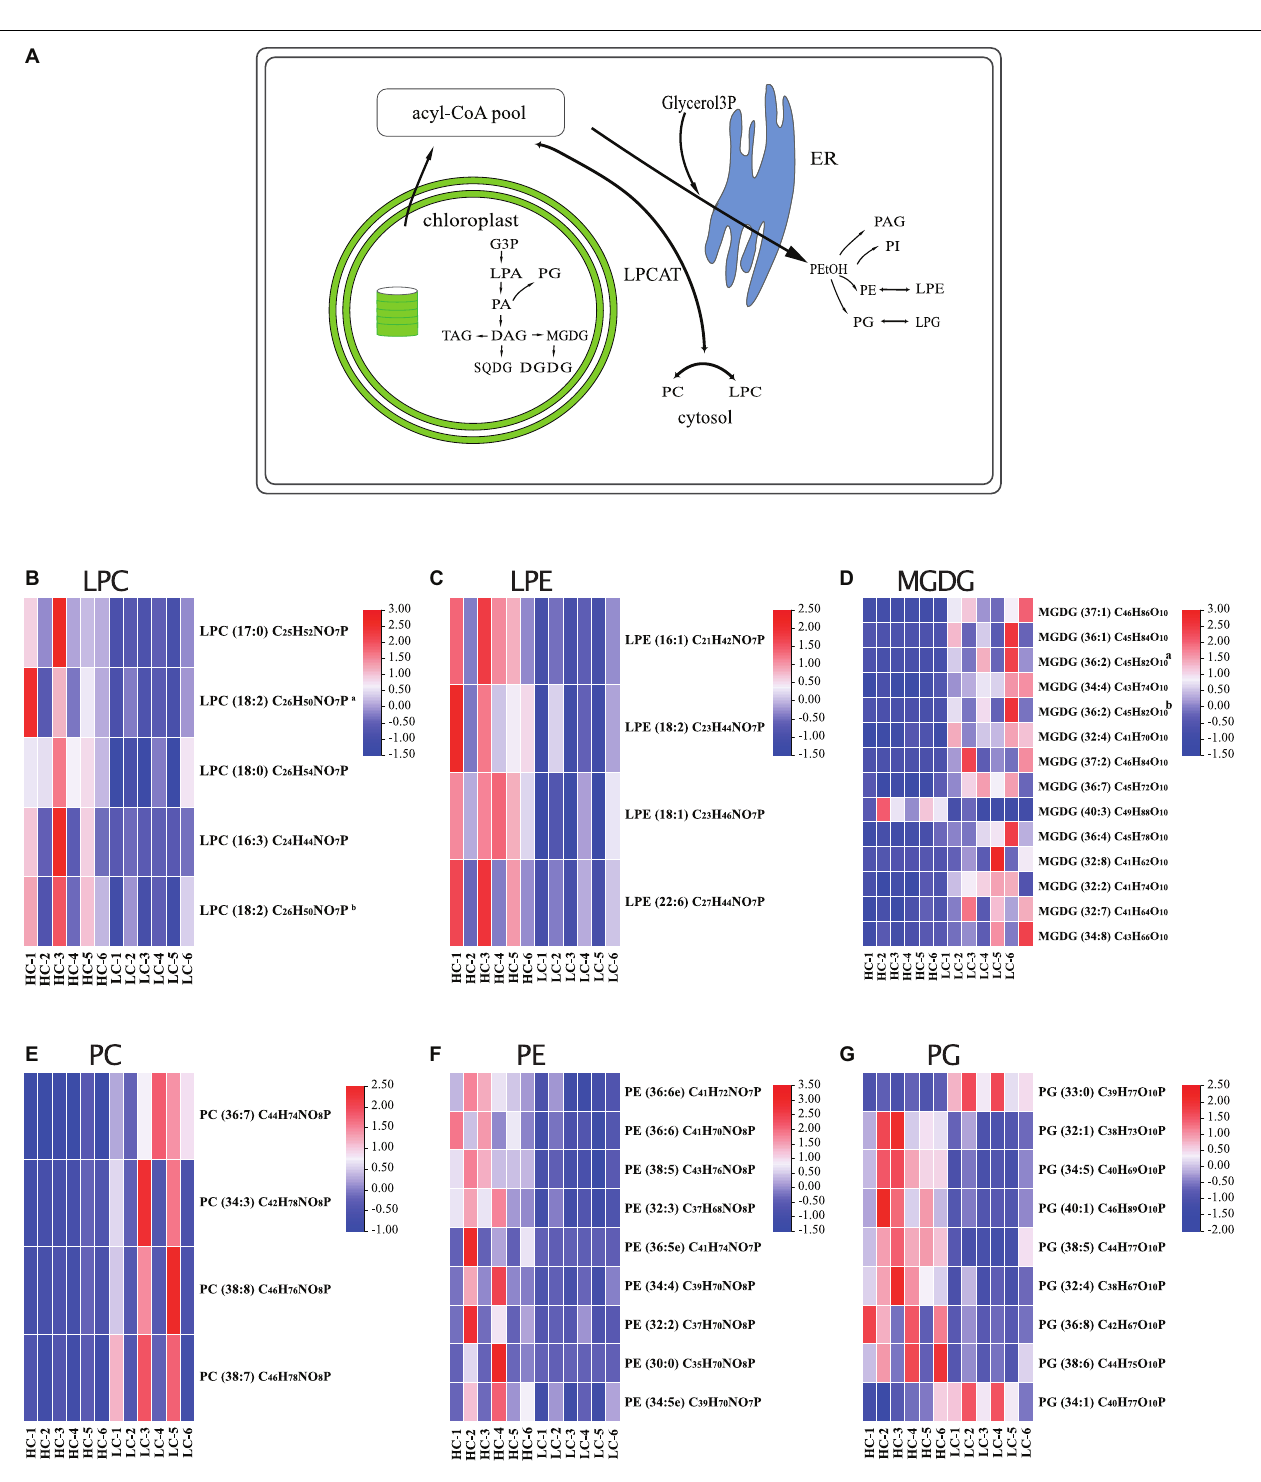
FIGURE 4 | (A) Model of lipid metabolism changes in Phaeodactylum tricornutum after long-term high CO 2 selection. The heatmaps display the log 2 -fold changes in lysophosphatidylcholine [LPC, (B) ], lysophosphatidylethanolamine LPE (C) , monogalactosyldiacylglycerol [MGDG, (D) ], PC, phosphatidylcholine [PC, (E) ], phosphatidylethanolamine [PE, (F) ], and phosphatidylglycerol [PG, (G) ].